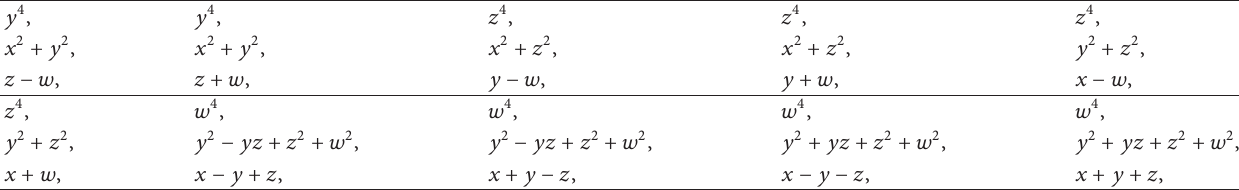
Table 2: Irreducible components corresponding to